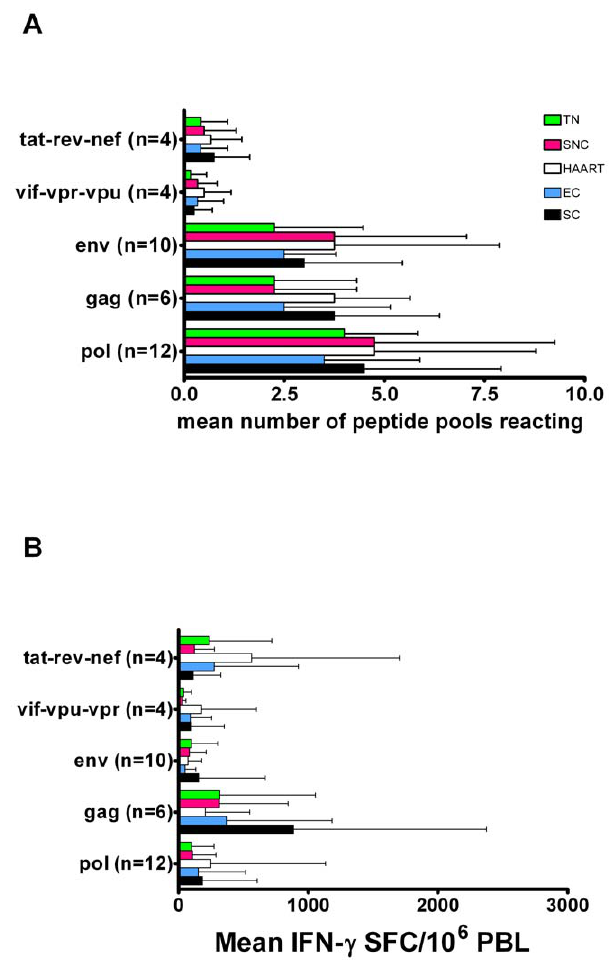
Figure 3. Breadth and magnitude of T cell responses against HIV peptides. (A) To evaluate T cell response breadth, PBMC from different patient groups were stimulated with peptide pools spanning the whole HIV genome. In the Y-axis the number of pools tested for each gene or gene group is indicated. In the X-axis the mean number ( + SD) of peptide pools inducing positive ELISPOT responses in the HAART, TN, SNC, EC and SC patient groups is represented. (B) Based on the same dataset, the magnitude of the response was calculated as the mean number of IFN- c spot forming cells (SFC) per million PBMC for each group of patients. Only peptide pools against which a positive response was measured, were included in this calculation. For each patient the SFC of positive peptide pools within each protein were cumulated and the mean ( + SD) within each patient group is represented. No statistical differences were